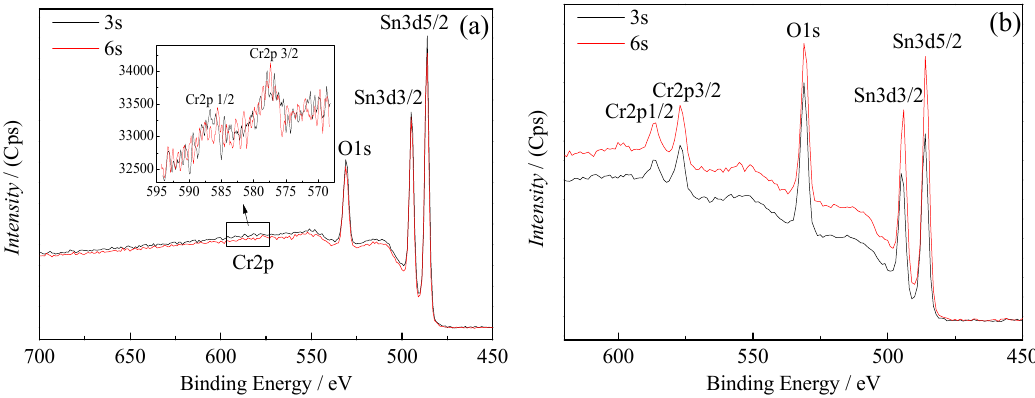
Figure 12. XPS survey spectrogram of the tinplate surface treated with ( a ) chemical passivation for different times and ( b ) electrolytic passivation for different times. Table 4. Binding energy (eV) of the XPS peaks by surveying the tinplate surface treated with different passivation processes.